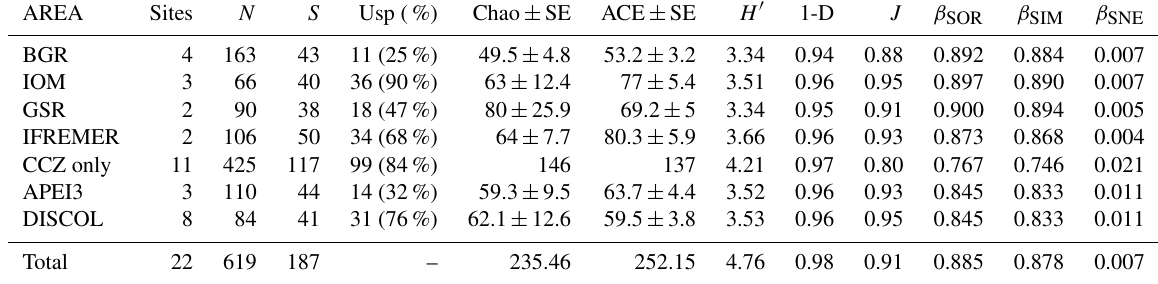
Table 1. Summary of diversity parameters per sampled area. “Sites” signifies number of epibenthic sledge deployments, N signifies number of specimens, S signifies number of species, “Usp” signifies number of unique species, Chao ± SE signifies Chao estimated number of species with standard error, ACE ± SE signifies ACE estimated number of species with standard error, H (cid:48) signifies Shannon diversity, 1-D signifies Simpson’s diversity, and J signifies Jaccard’s evenness. β SOR , β SIM , and β SNE express multiple-site total beta diversity, multiple- site species turnover, and multiple-site nestedness, respectively. Note that in the rows of each area, the beta-diversity values are the result of excluding this area except for the rows “Total” (which includes all areas) and “CCZ only” (which includes all but APEI3 and